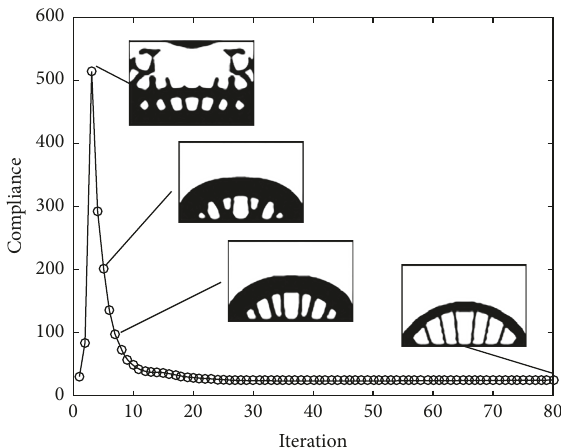
Figure 11: Iteration history of structural compliance for form finding of through arch bridge.